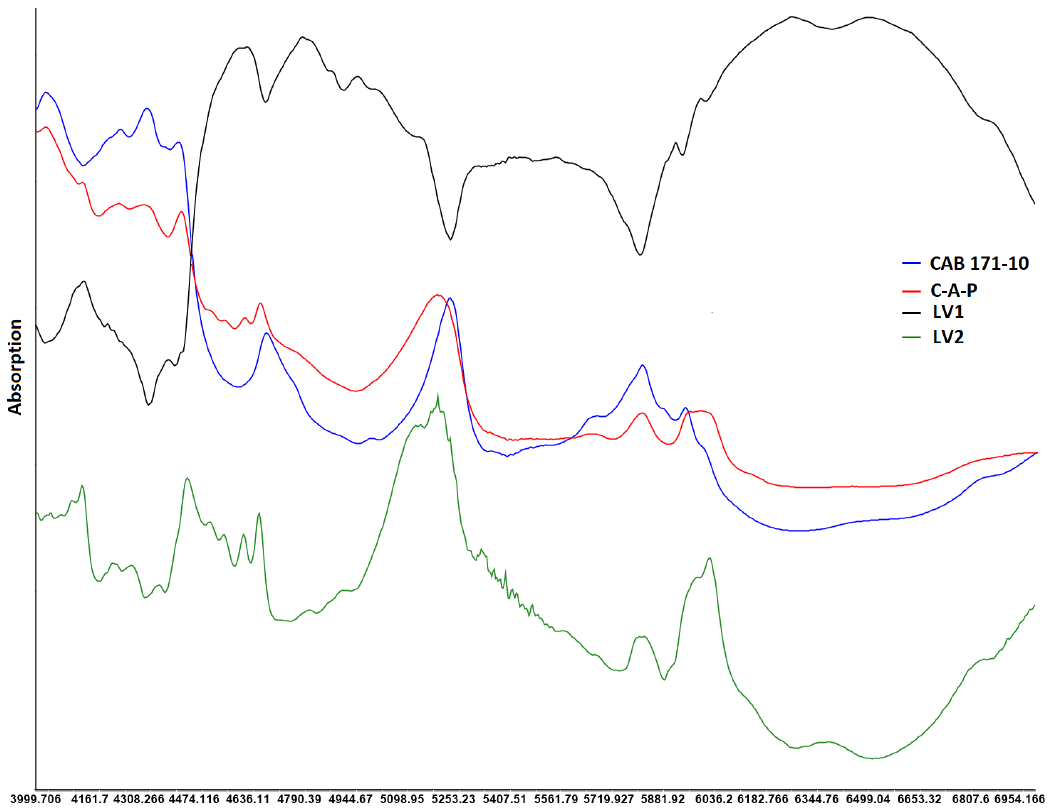
Figure 8. NIR spectra of latent variables and coating components.